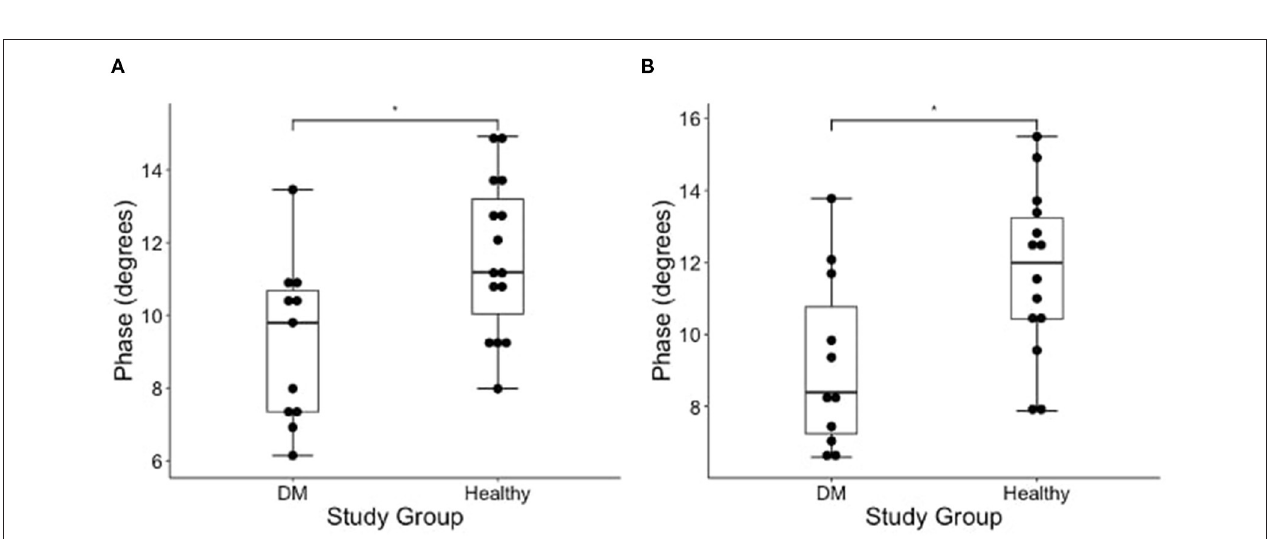
FIGURE 3 | Boxplot of the EIM phase measurements (degrees) obtained from average of all measured pelvic limb muscles on the (A) left and (B) right side muscles in DM dogs and healthy dogs using Wilcoxon rank sum test. There is a significantly lower phase of the DM affected dogs as compared to healthy control dogs in both pelvic limbs [*indicates significance; p -value 0.012 (left) and 0.021 (right)]. =